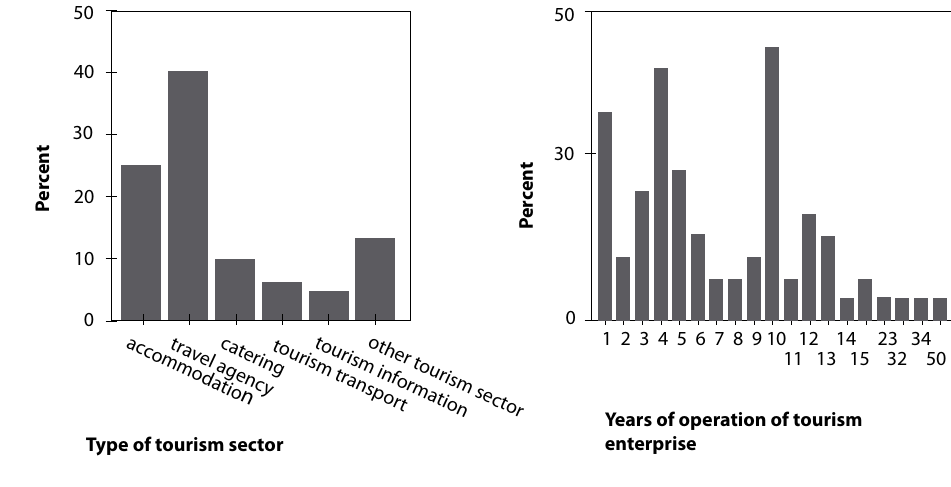
Fig. 2. Surveyed Latvian tourism enterprises divided by tourism sector, 2004